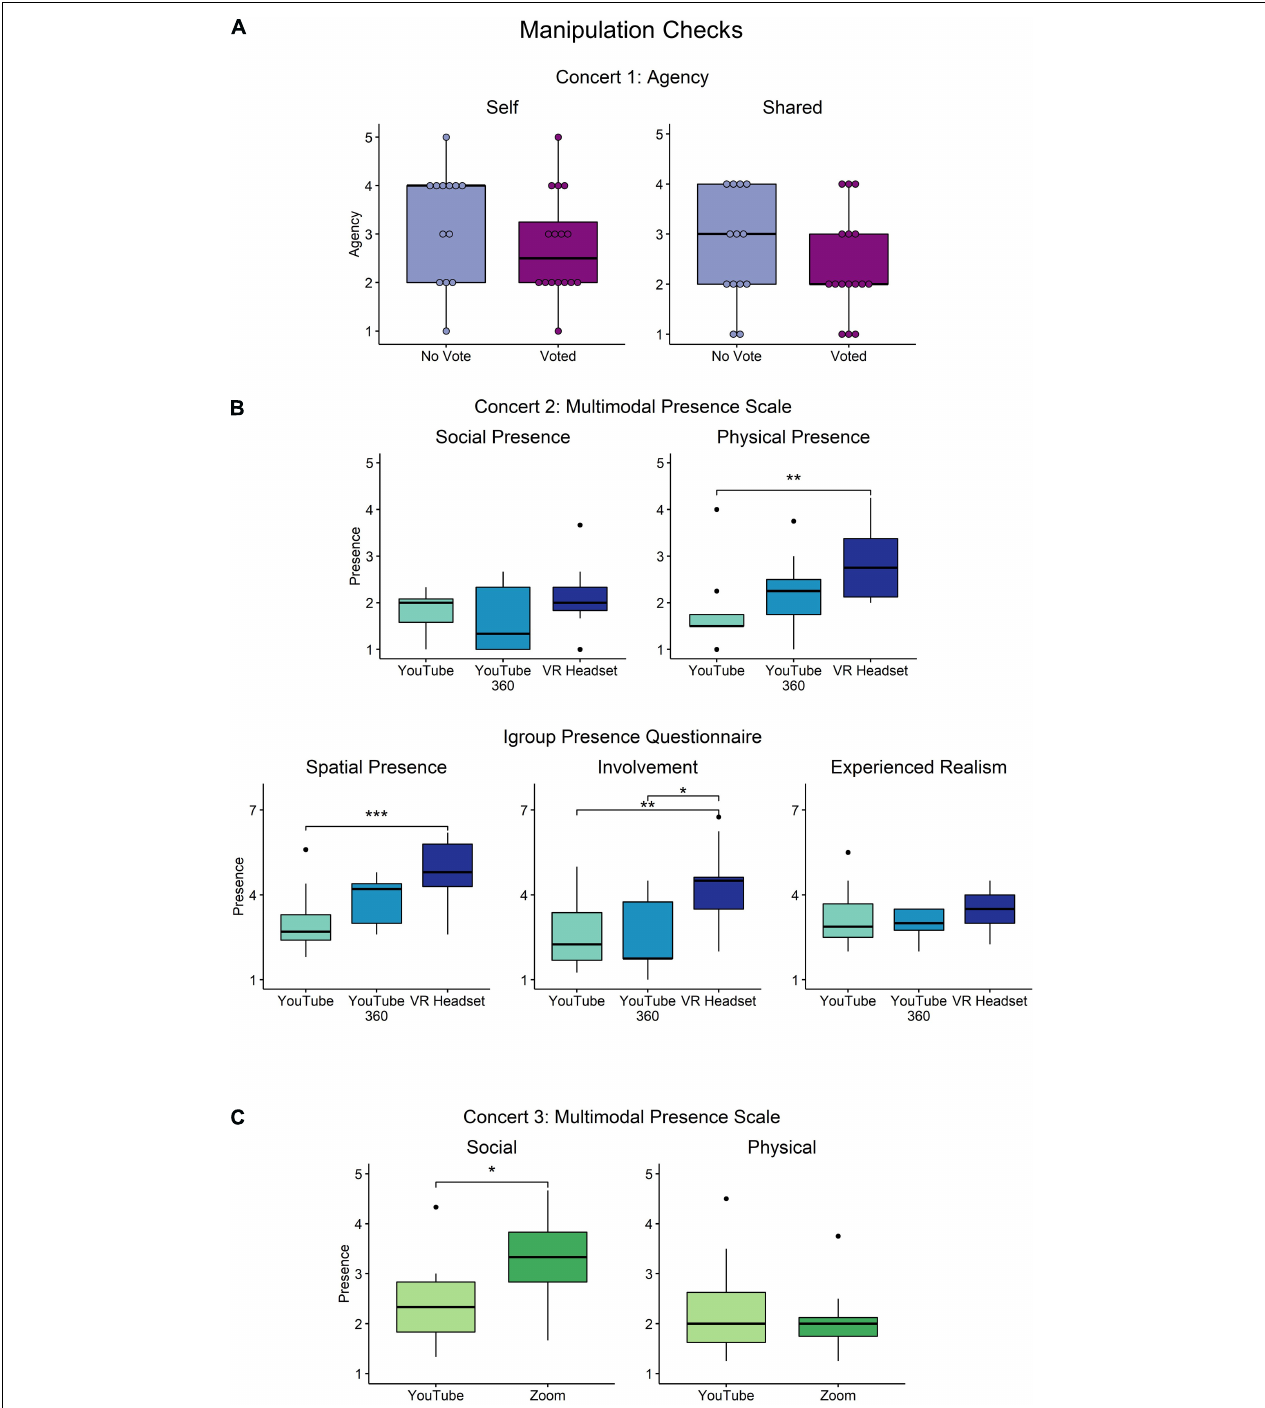
FIGURE 2 | (A) Concert 1: The manipulation of voting was not effective in producing differences in self- or shared agency. (B) Concert 2: The manipulation of using a VR headset was effective in increasing physical presence (MPS), spatial presence (IPQ), and involvement (IPQ) relative to a regular YouTube livestream. (C) Concert 3: The manipulation of social context by viewing in Zoom was successful in increasing social presence. The BH method was used for adjusting p -values. *** p < 0.001, ** p < 0.01, * p < 0.05.